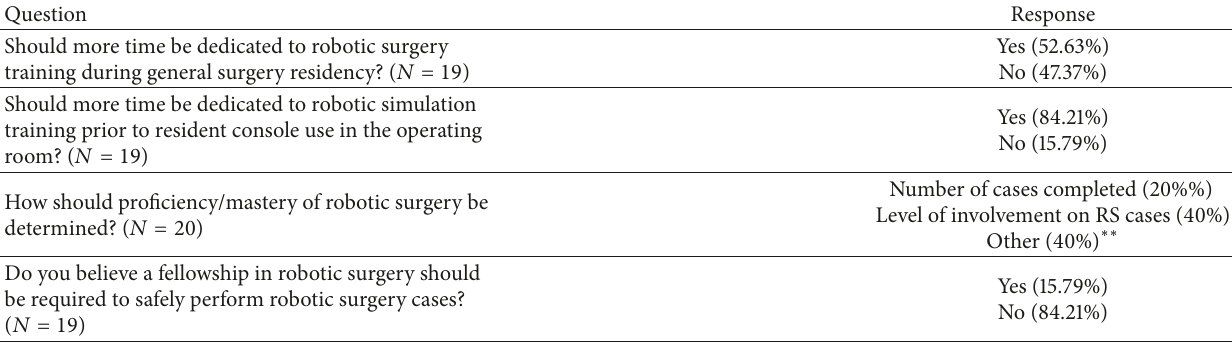
Table 5: Views on robotic surgery education